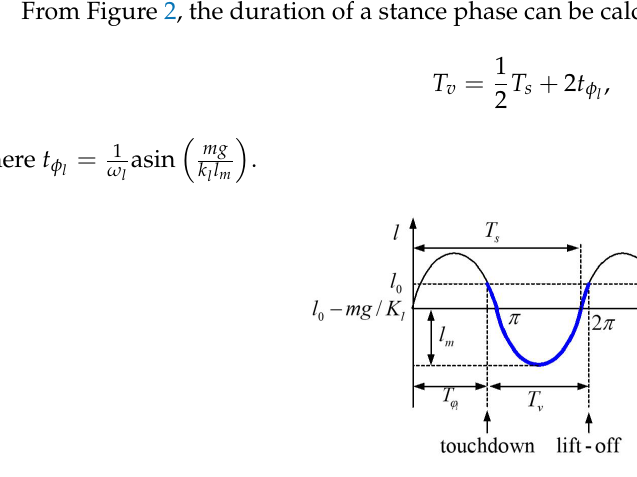
Figure 2. Diagram of harmonic vibration of the linear spring